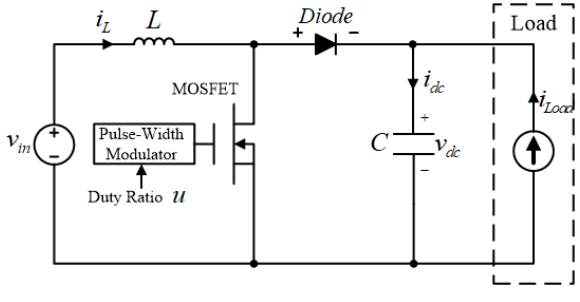
Figure 1. DC/DC boost converter